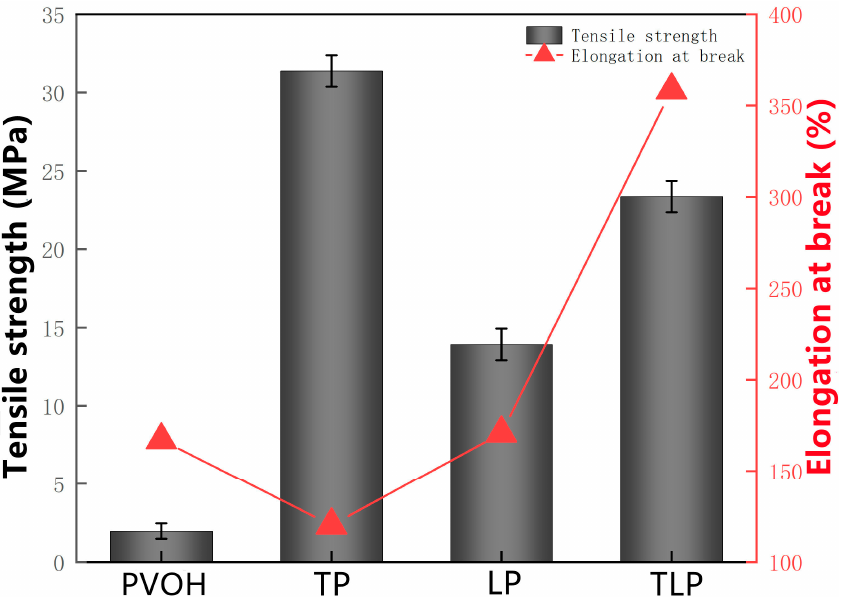
Figure 6. Tensile strength and elongation at break of the different films.